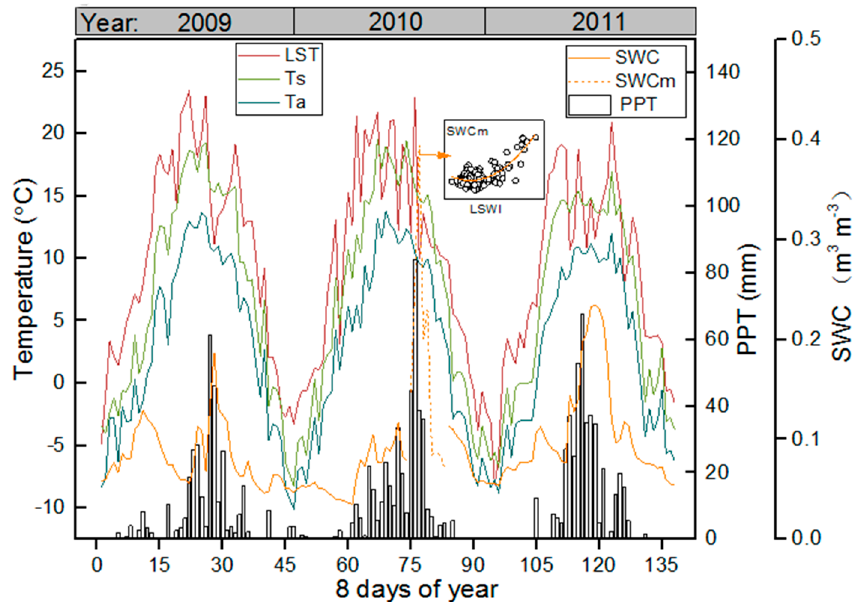
Figure 3. Temperature and moisture conditions from 2009 to 2011 in this alpine meadow. LST is the land surface temperature that is the average of daytime and nighttime land surface temperature. Ts and Ta are soil temperature at the depth of 5 cm and air temperature at the height of 2 m, respectively. PPT is precipitation. SWC is the soil water content. SWCm is the modeled SWC for its missing value from land surface water index (LSWI) as the inset shows (SWCm = 0.1411 + 1.133 * LSWI + 4.611 * (LSWI) 2 , R 2 = 0.61, p <0.0001, n = 129). Data are eight-day composited and showed with the first day of each eight-day interval in horizontal axis (hereafter the same).